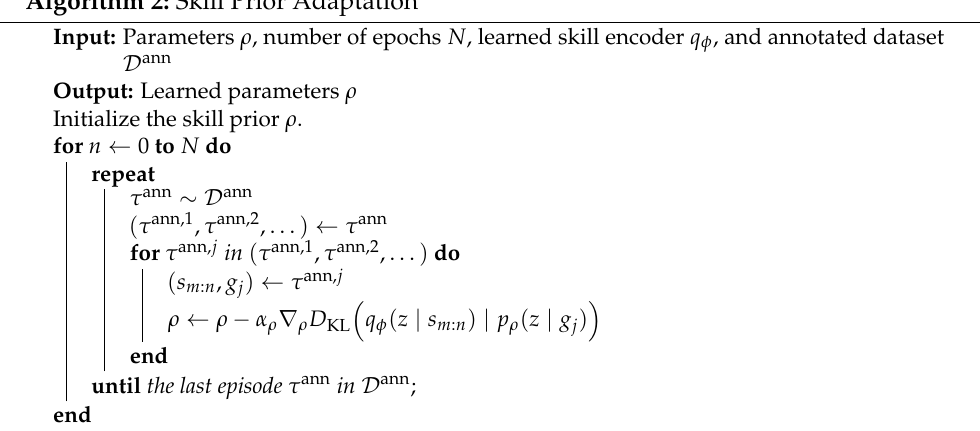
Algorithm 2: Skill Prior